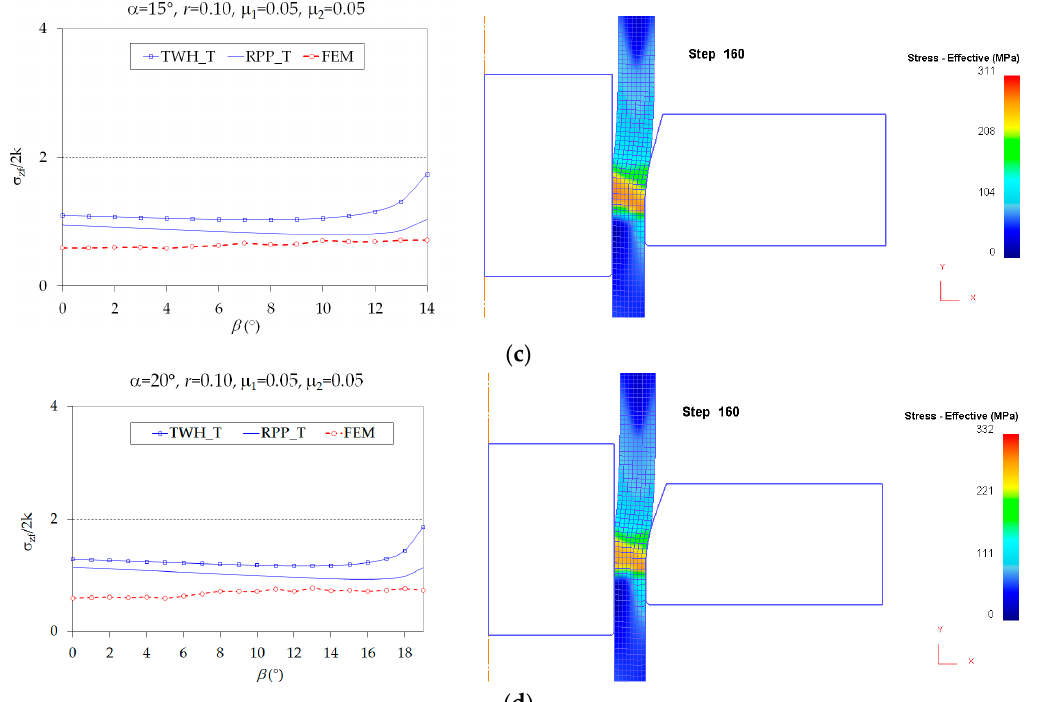
Figure 8. Validation of UBM model by FEA for different die semiangles α and fixed conical plug semiangles β ( r = 0.10; µ 1 = 0.05; µ 2 = 0.05; and copper alloy UNS C11000) and their corresponding effective stress contour diagrams obtained by DEFORM for β = 0 ◦ : ( a ) α = 5 ◦ ; ( b ) α = 10 ◦ ; ( c ) α = 15 ◦ ; and ( d ) α = 20 ◦ .